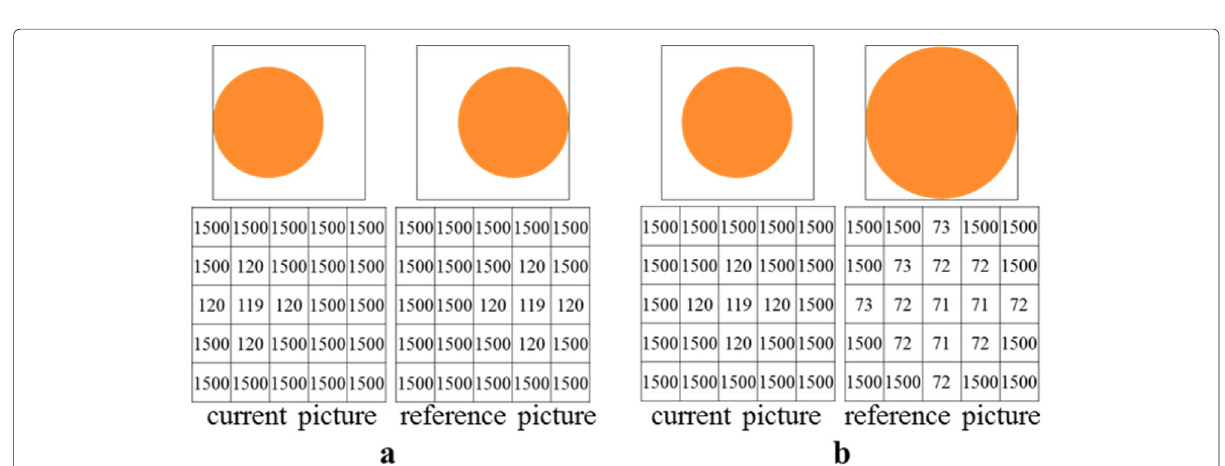
Fig. 6 Pixel values in depth pictures including an object a when object moves in parallel and b when object has zoom